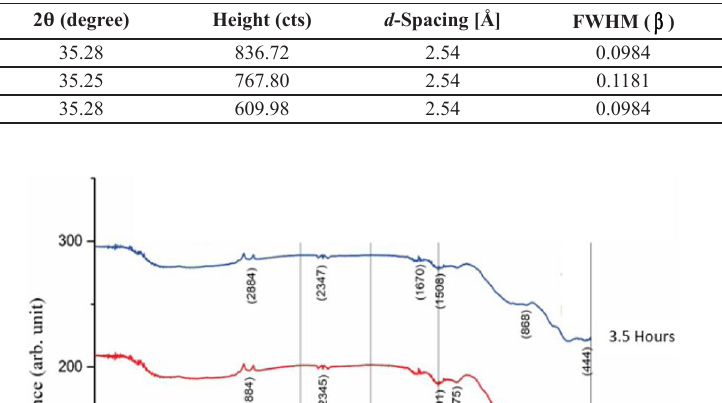
O Crystal Characteristics Obtained from XRD Analysis 2 4